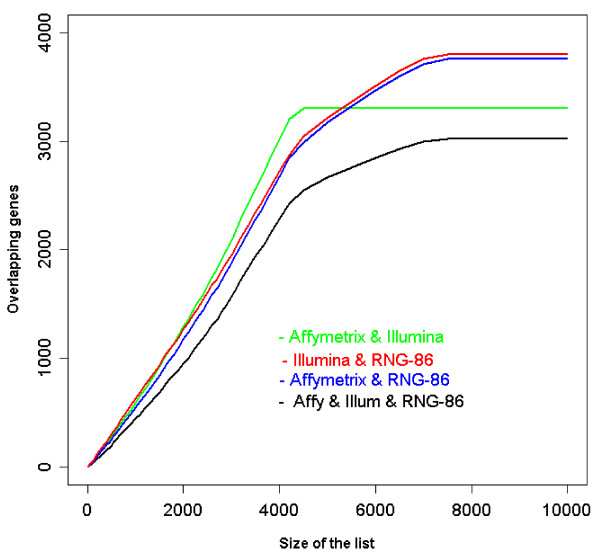
Effect of gene list selection criteria on the degree of inter-platforms concordance. Number of overlapping genes (y-axis) in the 2 and 3 lists of DEG according to the size of the list (x-axis). For each platform, the list was constituted by selecting DEG (Pc < 0.05), then within this list genes were ranked according to decreasing fold change. The number of overlapping genes between lists was calculated for increasing list size. When the number of probes in the lists was approximately 3800, the number of overlapping genes reached a plateau. The "best 3800" set of probes was defined accordingly.